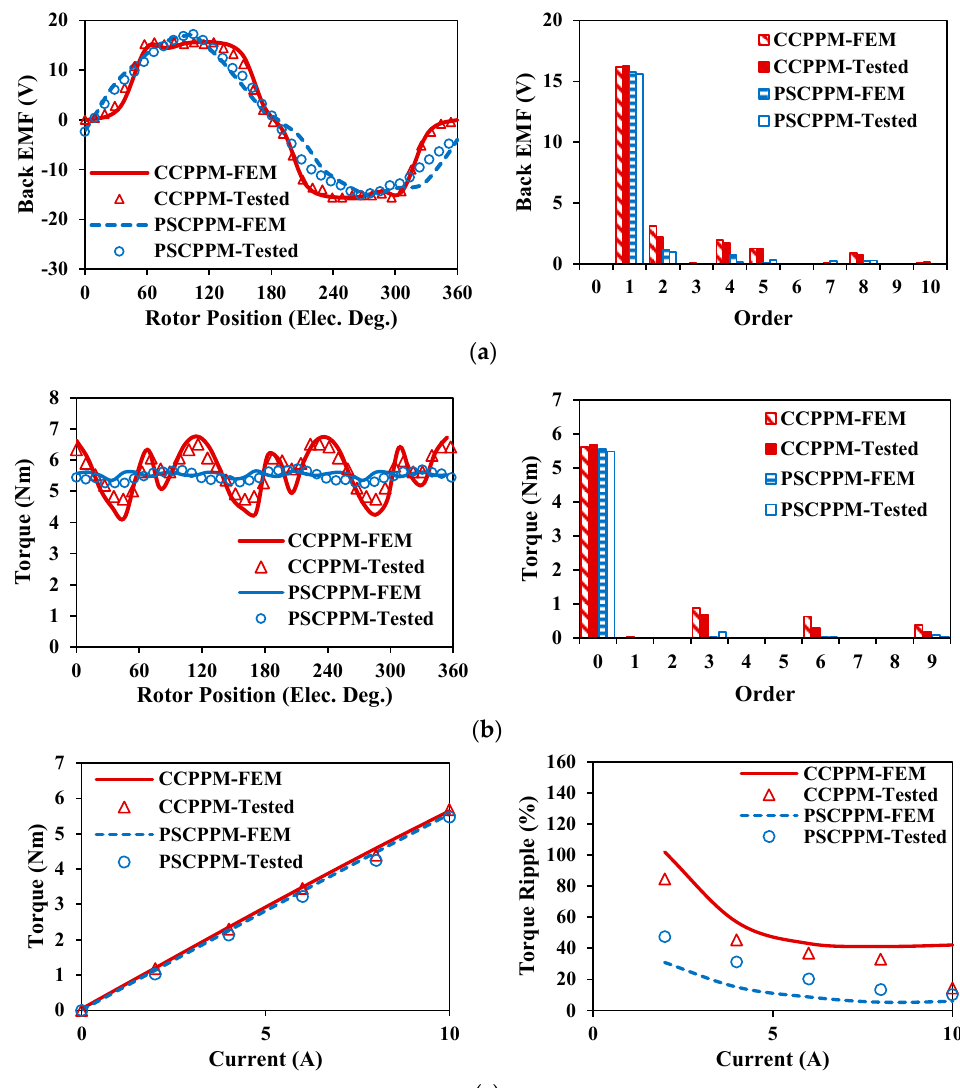
Figure 43. On load performances of 12s8p machines. ( a ) Back EMFs. ( b ) Rated torques (10A). ( c ) Torque performances under different current.